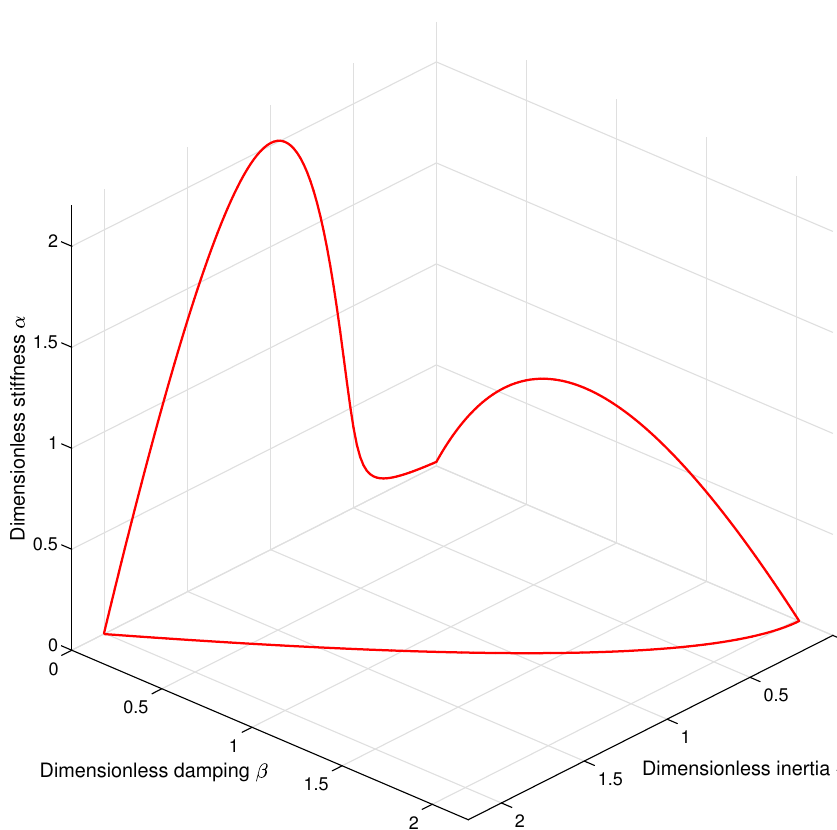
Figure 5. Stability boundaries for virtual spring-mass-damper